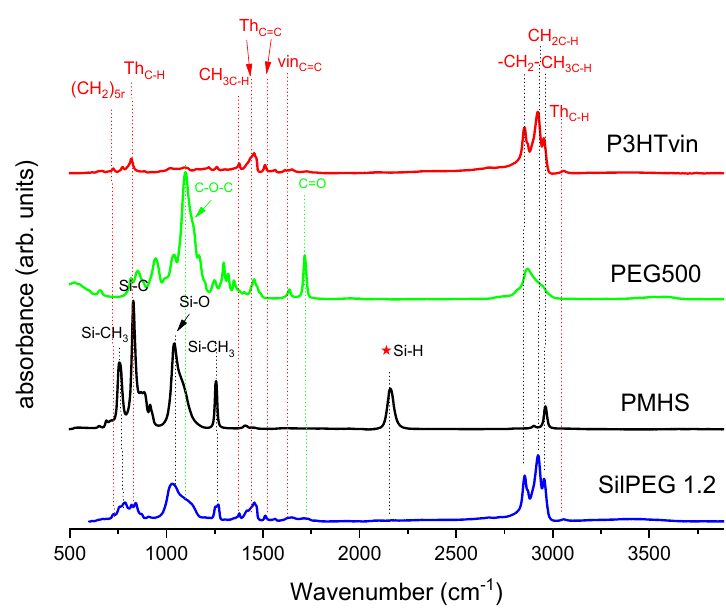
Figure 2. IR-ATR of poly(methylhydrosiloxane)-graft-[poly(3-hexylthiophene); poly(ethylene glycol) methyl ether methacrylate] (PEG average M n ≈ 500) (SilPEG 1.2). methyl ether methacrylate] (PEG average M n ≈ 500) (SilPEG